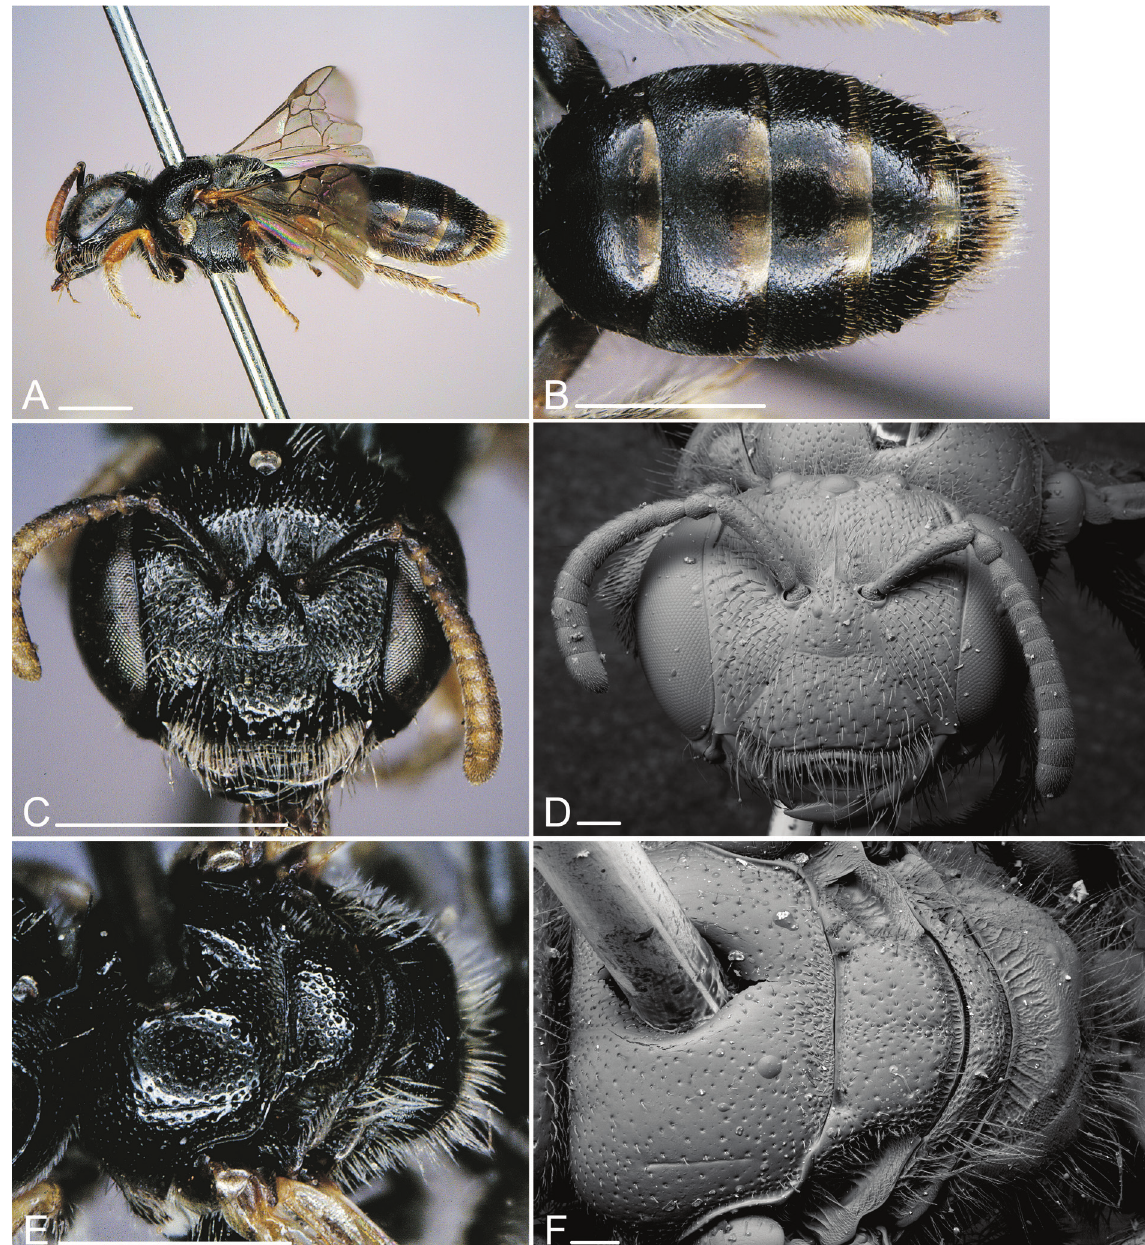
Fig. 28. Scrapter sittybon Davies, 2005, ♀. A . Lateral view. B . Metasoma (dorsal view). C . Head. D . Head (SEM). E . Thorax (dorsal view). F . Thorax (dorsal view, SEM). Scale bars: photos: 1 mm, SEM: